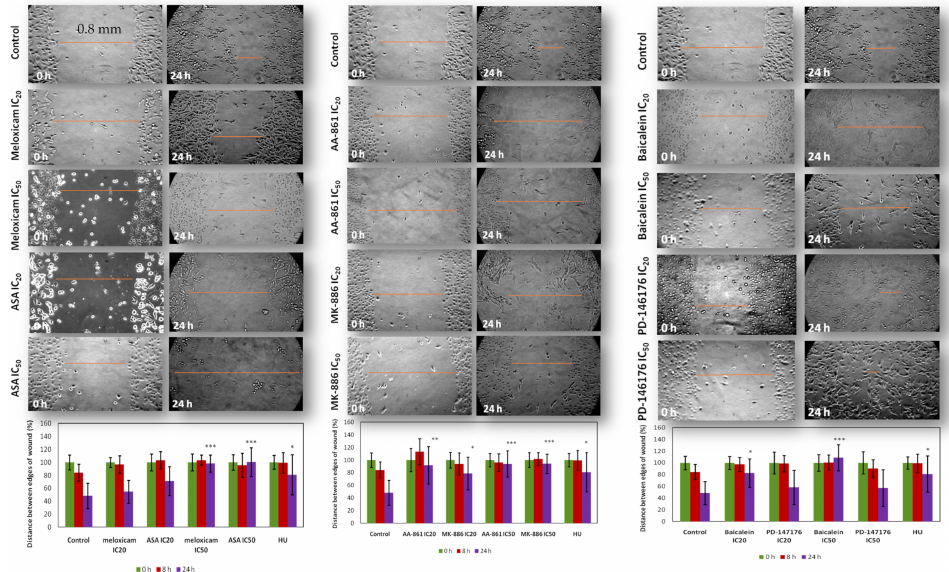
Figure 10. In Vitro effect of COX and LOX inhibitors on B16F10 cell 2D migration/motility. ( Top ) Time lapsed images of the scratch/wound after treatment. In orange, a representative mea- surement ( Bottom ) Distances between edges of the scratch (in %) of B16F10 cells after treatment (average of five random measurements per replicate). All quantitative values are the mean of three independent assays run in duplicate. Error bars represent SD. Statistical significance by two-tailed unpaired t -test with 95% confidence interval (*** p < 0.001 ** p < 0.01 * p < 0.05). The COX inhibitors were not able to inhibit cell directional migration/motility at toxic concentrations ( p < 0.01) only. In contrast, the two 5-LOX inhibitors were able to significantly inhibit cell directional migration/motility at both concentrations with AA-861 ( p < 0.01) having a greater significant effect than MK-886 ( p < 0.05) at non-toxic concentrations. Both inhibitors had the same significant inhibitory ( p < 0.001) effect at toxic concentrations